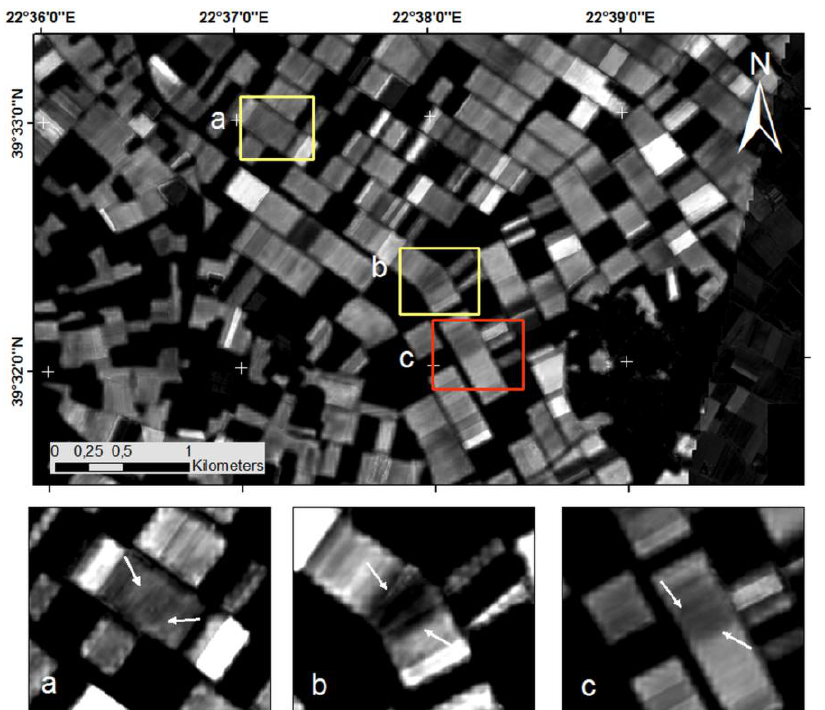
Figure 7. The simulated Sentinel-2 image over the Thessalian plain, based on the EO-Hyperion dataset. Known archaeological vegetation marks are indicated with yellow color, while another unknown vegetation mark is indicated in a red